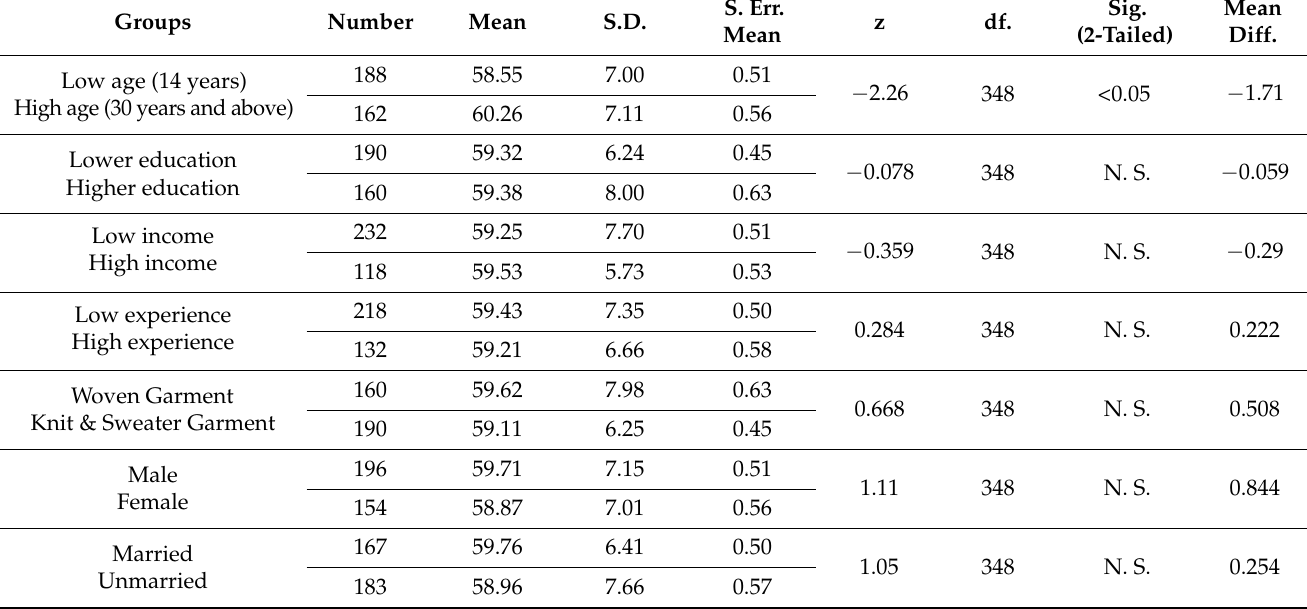
Table 3. The respondents’ (N = 350) mean differences in satisfaction according to some personal characteristics (age, education, income, experience, type of organization, sex, and marital